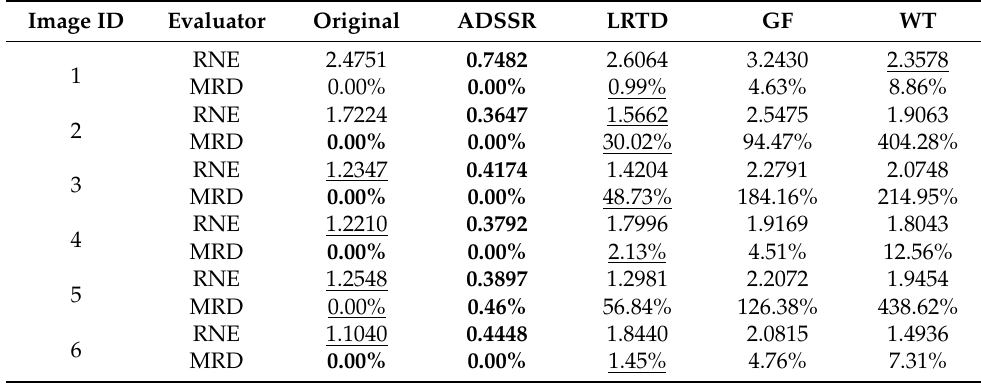
Table 4. Performance comparison of all competing